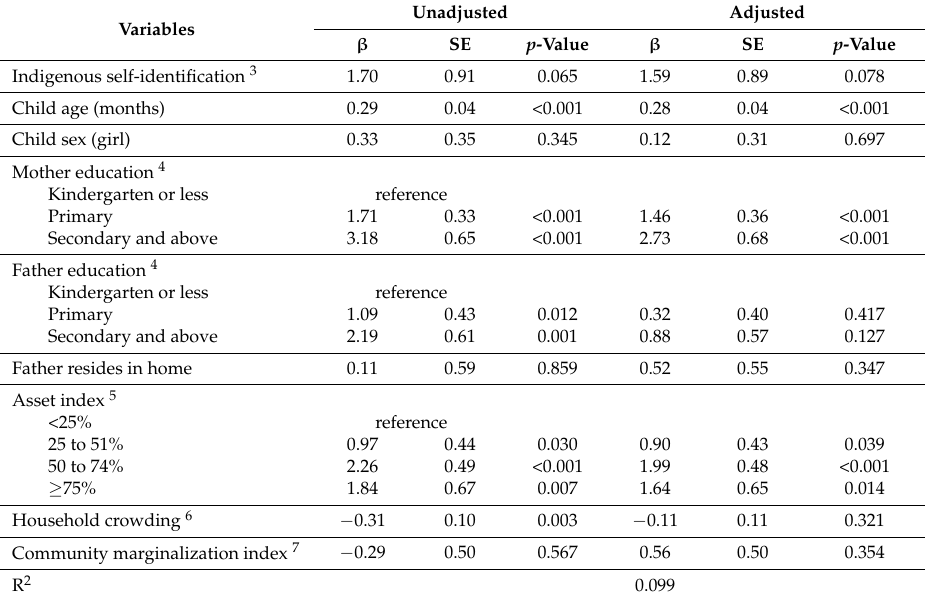
Table 4. Stratified Ordinary Least Squares (OLS) analysis of characteristics associated with variability in total HOME 1 Inventory score: Indigenous 2 communities ( n =